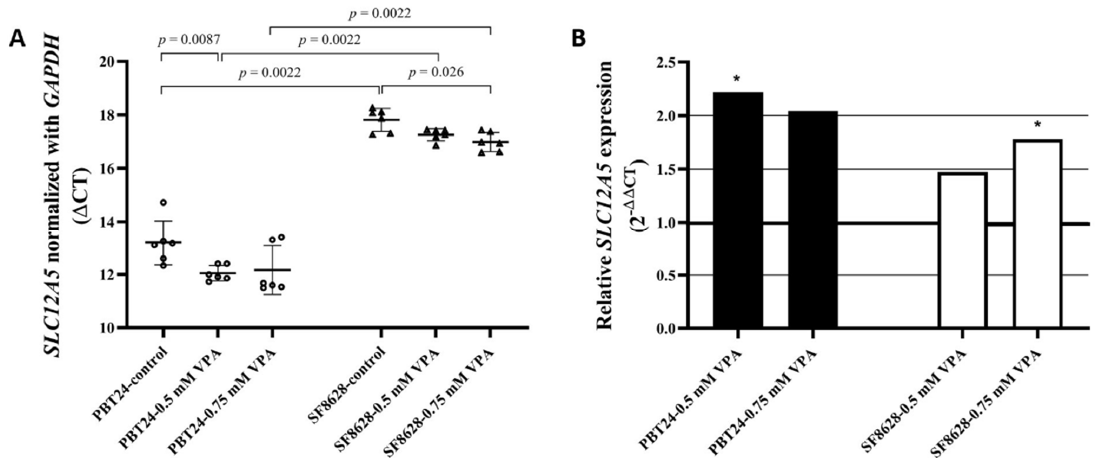
Figure 3. ( A ) SLC12A5 expression in PBT24 and SF8628 control groups and VPA-treated groups. Data are after normalization with GAPDH . Delta threshold cycle ( Δ CT) values were used for the graph (the horizontal bars represent the mean; the short horizontal lines show SD values). ( B ) The SLC12A5 relative expression in PBT24 and SF8628 VPA-treated groups compared with respective control. The 1.0 line shows the starting point of gene expression; * p < 0.05.